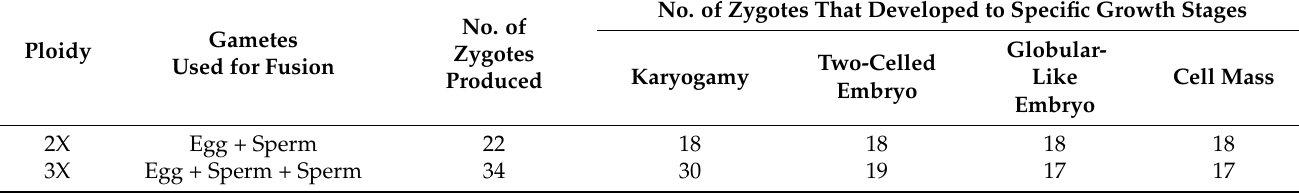
Table 1. Developmental profiles of diploid and polyspermic rice zygotes.